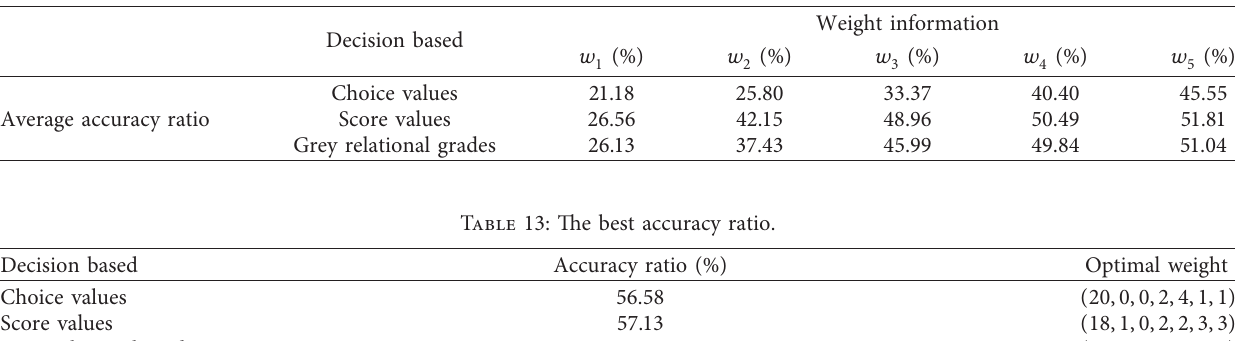
Table 12: The accuracy ratio of the location identification by Algorithm 5 with weight information.